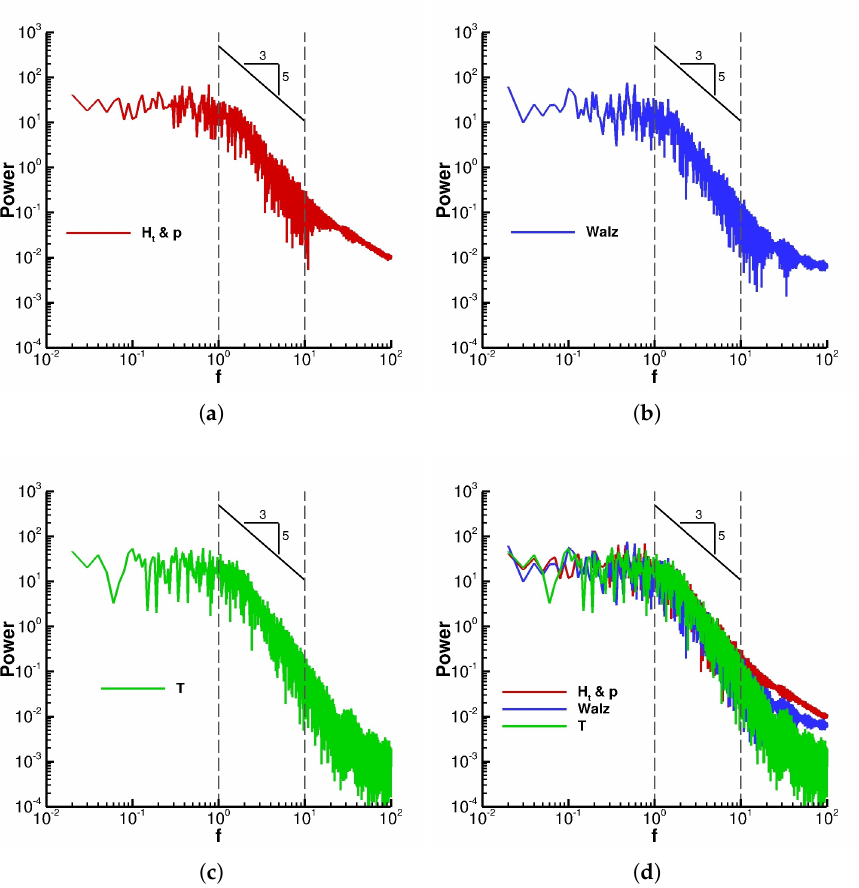
Figure 8. Effect of recycling-rescaling method on energy spectra for condition No. 2: ( a ) H t & p recycling-rescaling method. ( b ) Walz recycling-rescaling method. ( c ) T recycling-rescaling method. ( d )